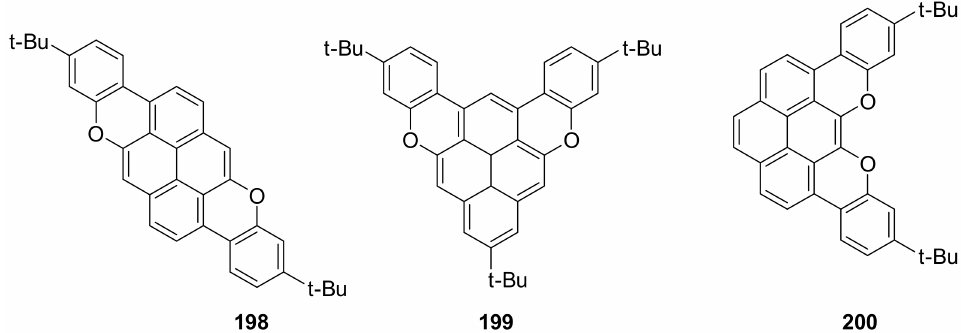
Figure 9. Structures of compounds 198 – 200 .